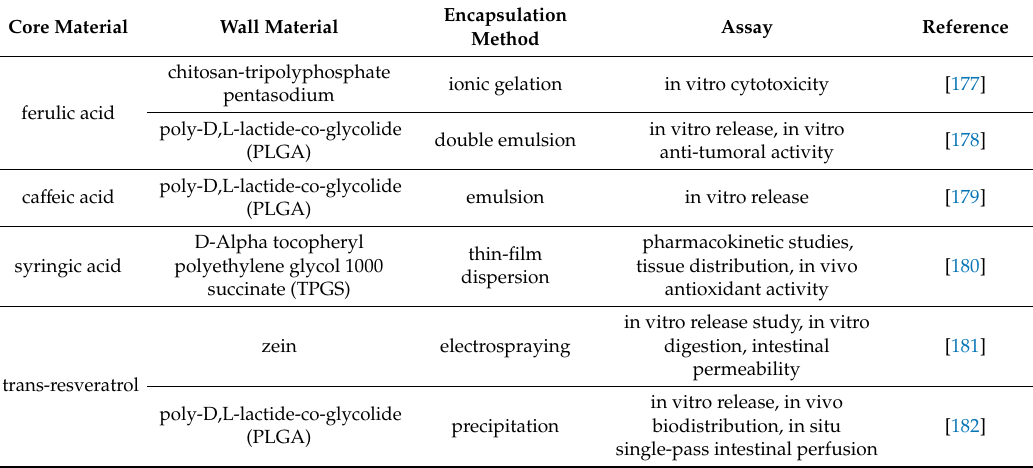
Table 1. Encapsulation of phenolic acids and stilbenes.